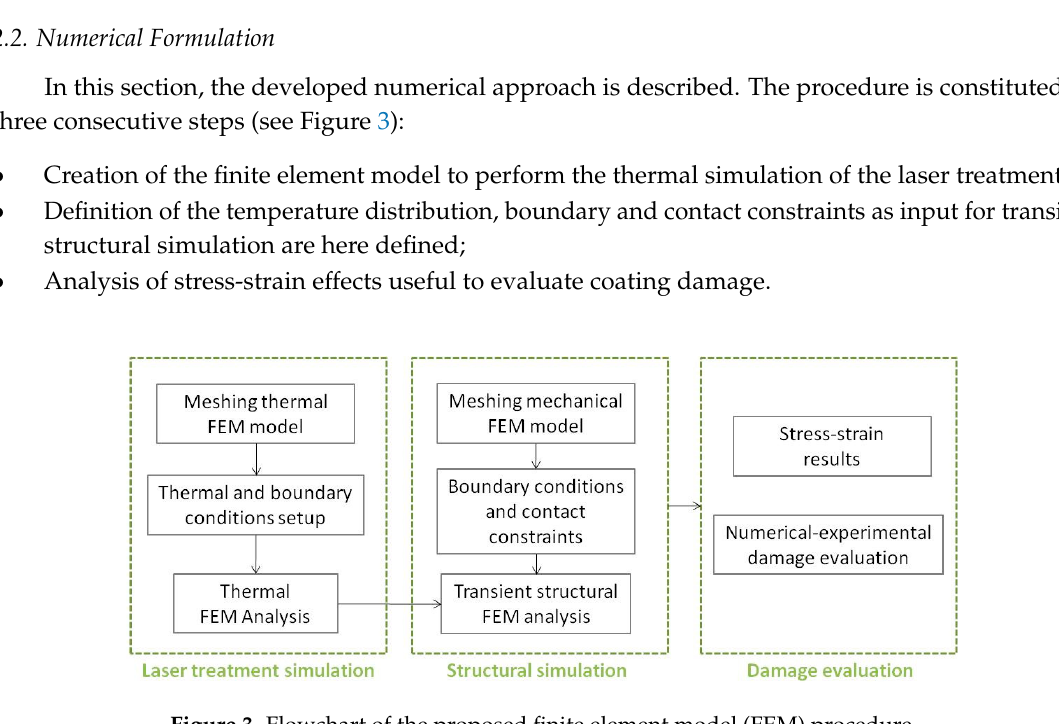
Figure 4. Structural meshed model of the coating-substrate system for the thermo-mechanical analysis.